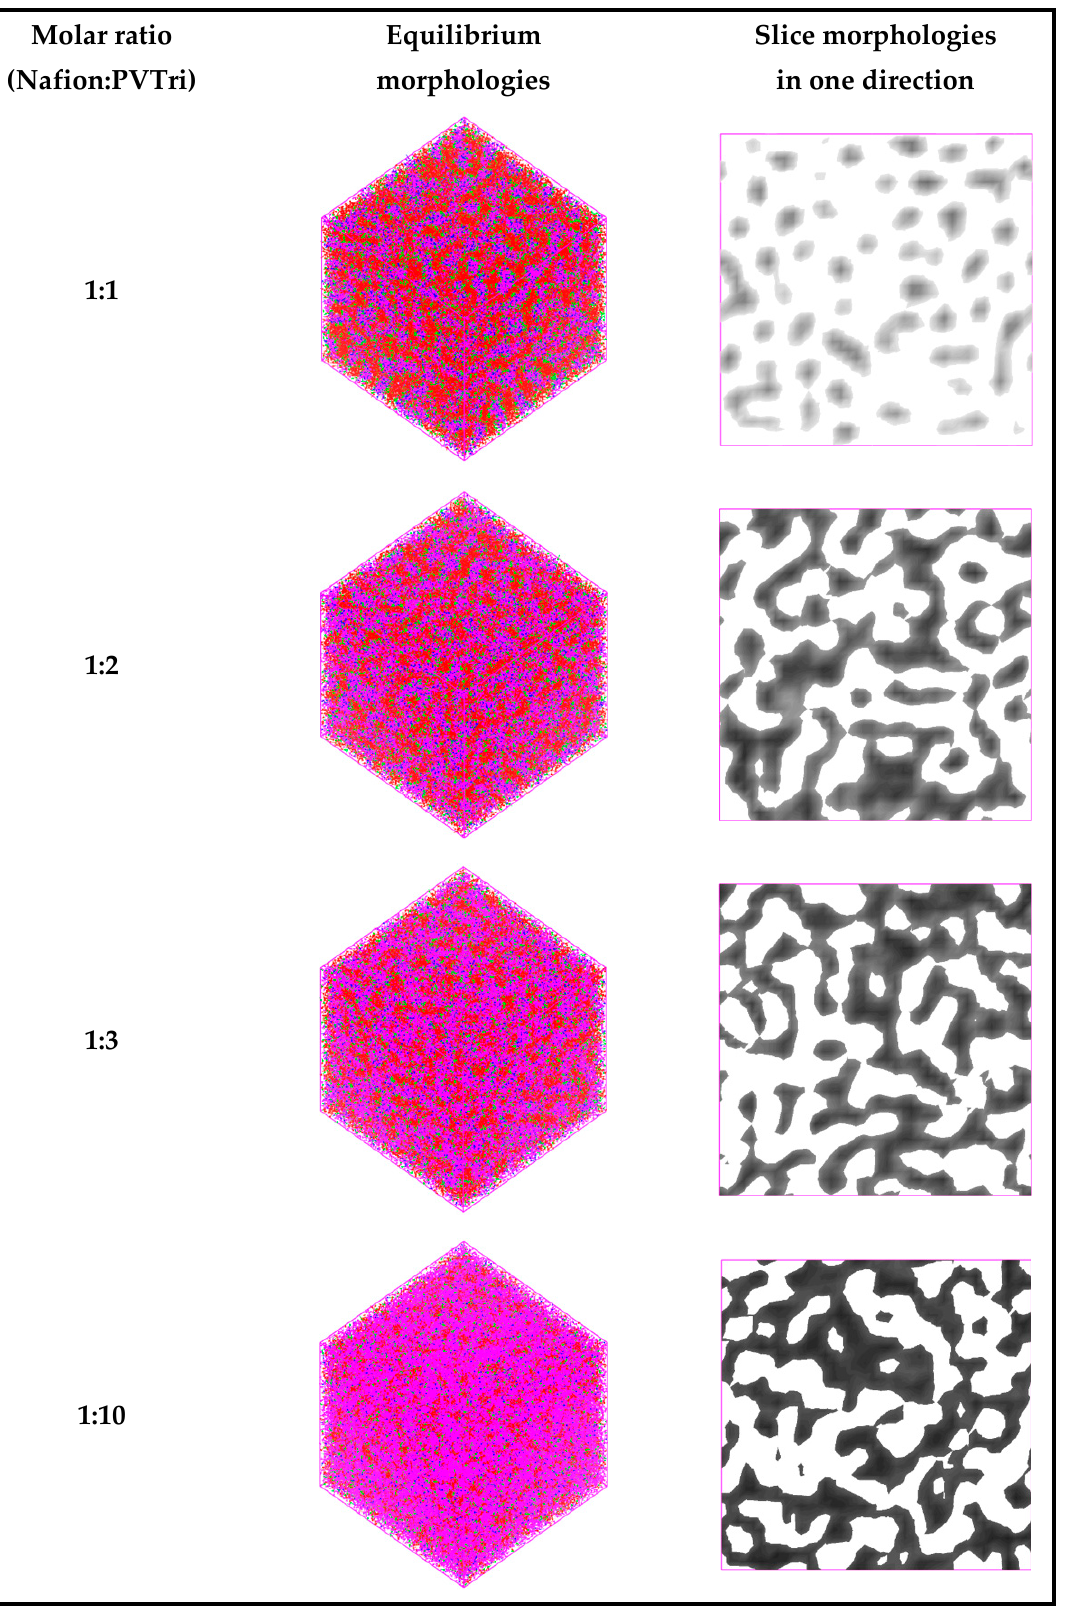
Figure 3. Comparison of equilibrium morphologies and slice morphologies of Nafion/PVTri blend membranes with various molar compositions.